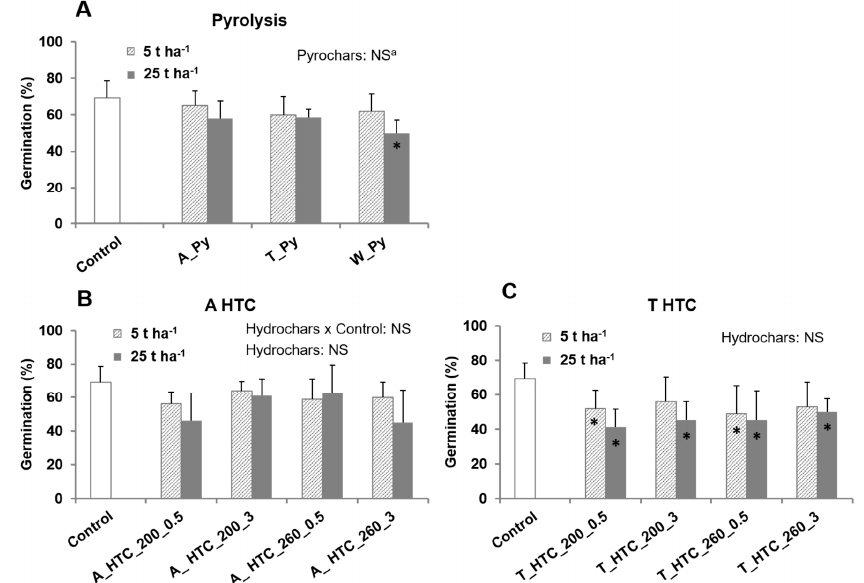
Figure 1. Germination rate (%) of Lolium perenne in: ( A ) Control and pyrochars-amended pots, ( B ) Control and pots amended with hydrochars derived from A_SS and ( C ) Control and pots amended with hydrochars derived from T_SS. Hydrochars were produced from primary (A_) and secondary (T_) sewage sludges at 200 °C (_HTC_200) and 260 °C (_HTC_260) for 0.5 and 3 h (_0.5, _3, respectively). Pyrochars were produced from primary (A_) and secondary (T_) sewage sludges (_Py). NS: no significance. Asterisks inside the bars show significant differences to the control according to the t -test. Agronomy 2019 , 9 , x FOR PEER REVIEW